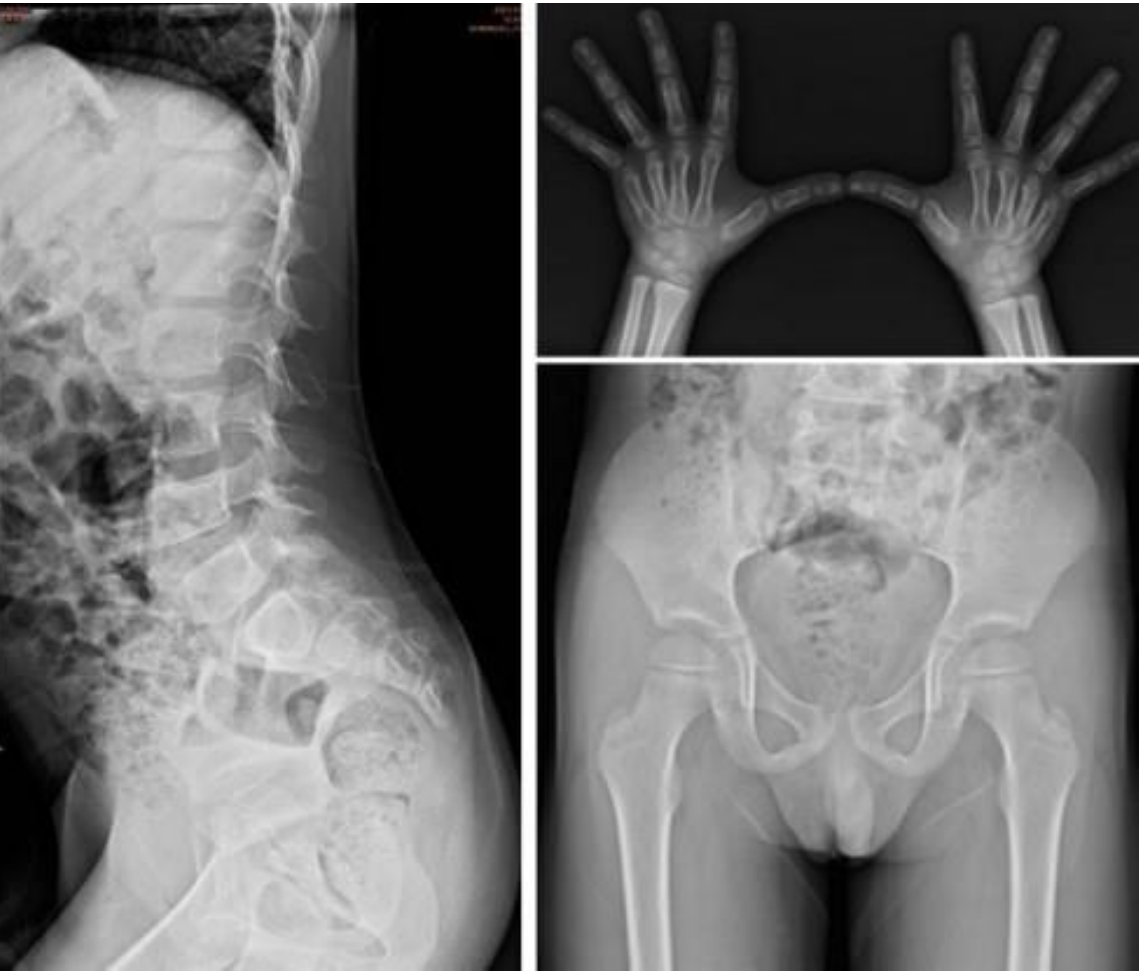
Figure 8. The bone X-rays at 6.1 years of age of subject No. II-8 who had the variation alleles c.103 + 34_56dup; c.684A > G [p.Pro228=]; c.851C > T [p.P284L]; c.1180 + 184T > C. At 6.1 years of age, X- rays of his spine, hands, and pelvis were all normal.